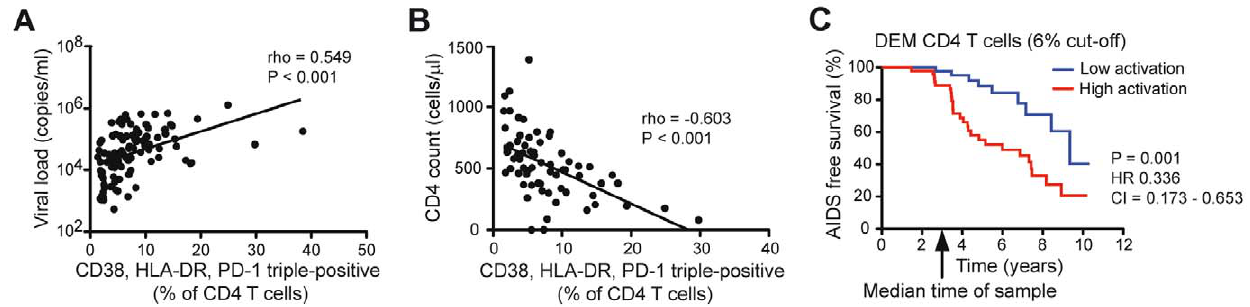
Figure 3. Levels of deregulated effector memory CD4 T cells correlate to and predict HIV-1 disease progression. (A) Spearman rank correlation between percentages of CD38, HLA-DR and PD-1 triple-expressing CD4 T cells and HIV-1 plasma viral load. (B) Spearman rank correlations between percentages of CD38, HLA-DR and PD-1 triple-expressing CD4 T cells and CD4 counts. (C) Kaplan-Meier analysis comparing the time to AIDS, as defined by CD4 T cell counts less than 250 cells/ m l of whole blood. HIV-1 positive subjects with CD38, HLA-DR and PD-1 triple-expressing CD4 T cells above the median (6%) were more likely to advance to AIDS (Log-rank =0.001, Hazard Ratio (HR) 0.336, 95% CI=0.173 to 0.653).